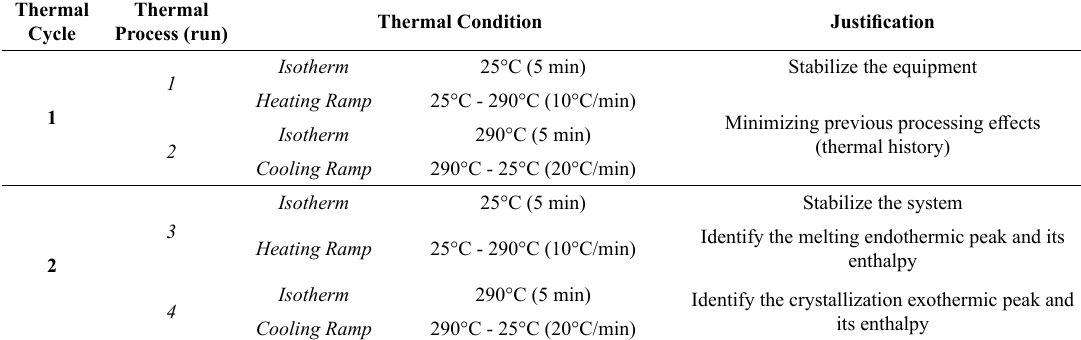
Table 1. DSC thermal